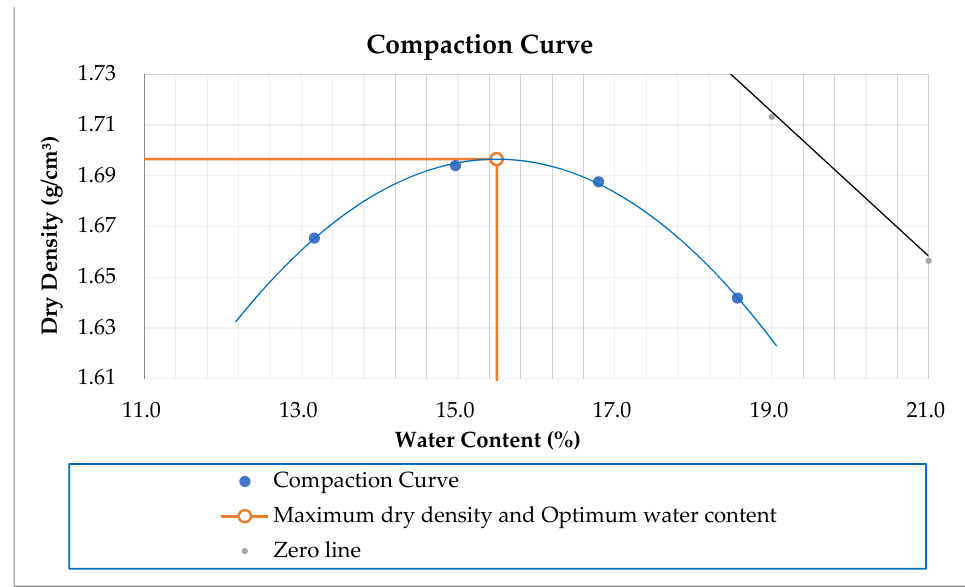
Figure 3. Soil Compaction Curve.